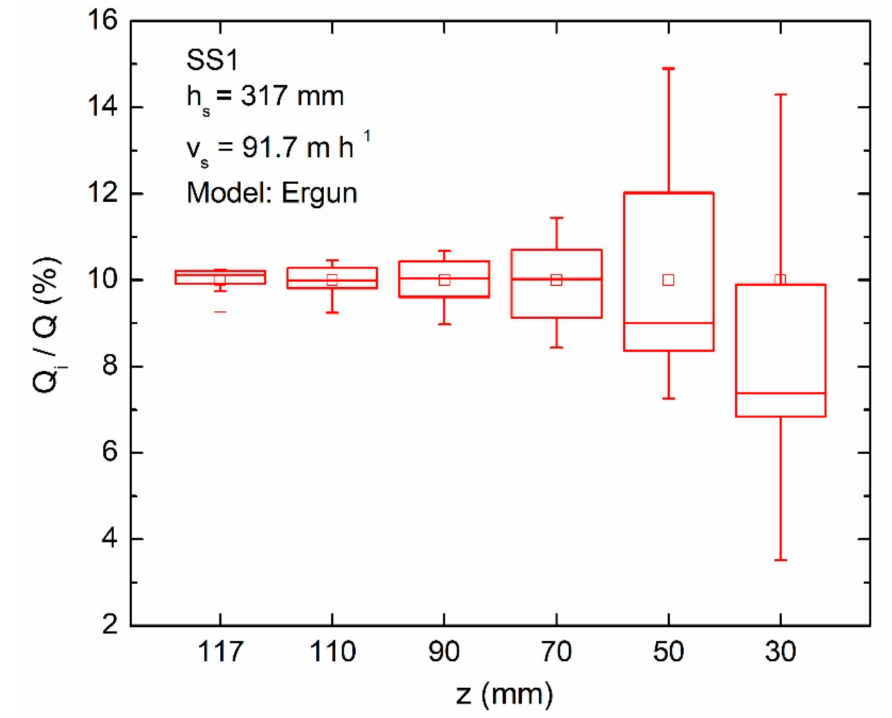
Figure 10. Box-plot of normalized volumetric flow rates through 10 horizontal annular plus circular centered sectors at different heights above the base plate. Case h s = 317 mm at Q = 0.8 L s − 1 and SS1 media with Ergun